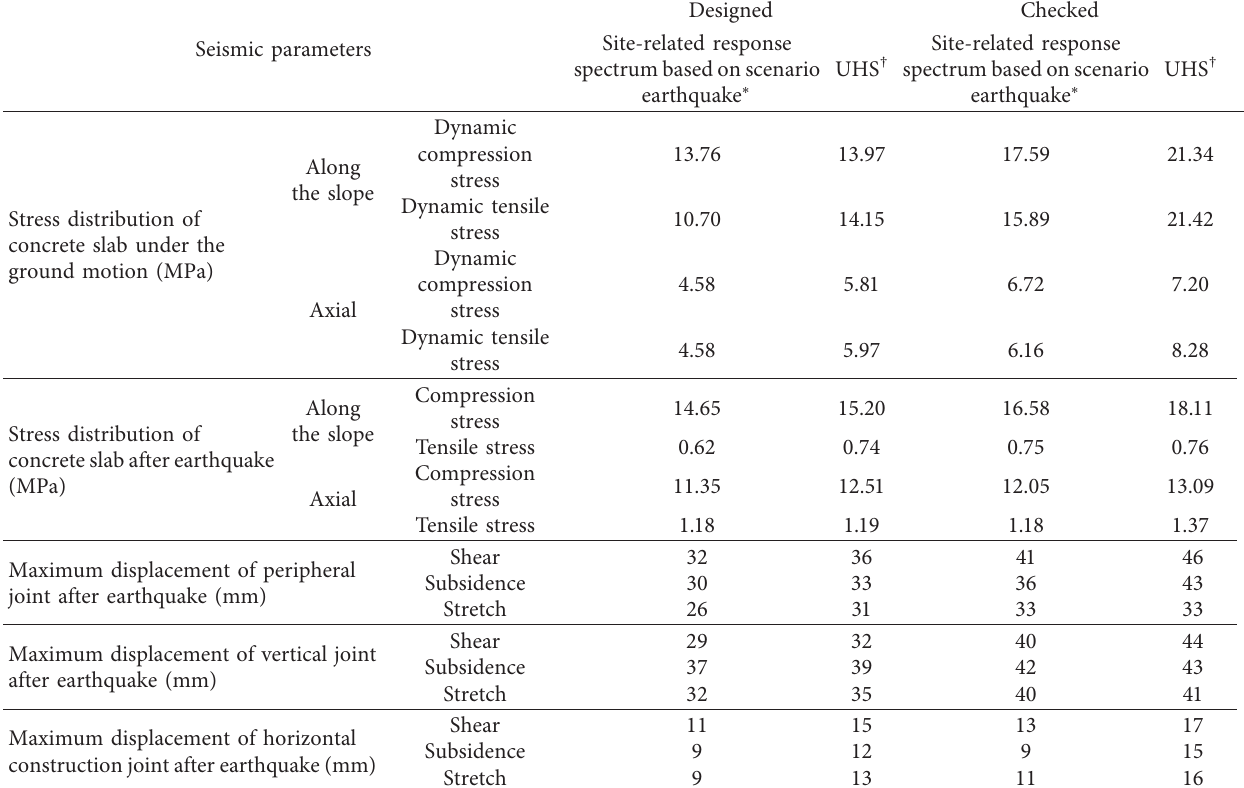
Table 5: Seismic safety of impervious